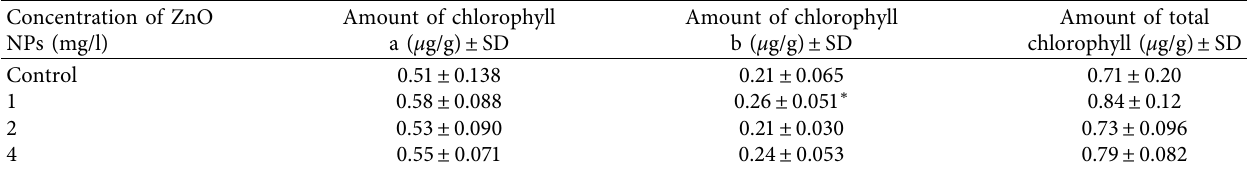
Table 2: Chlorophyll a and b and total chlorophyll content of samples of Triticum aestivum L. after exposure to ZnO NPs. Concentration of ZnO NPs